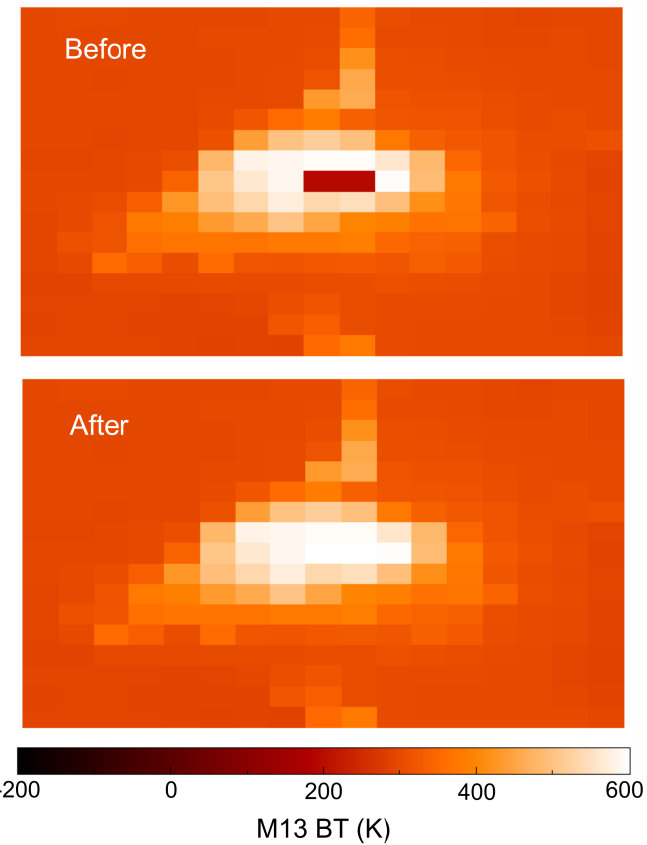
Figure 16. Comparison of M13 radiance (11 March 2014, 16:47 UTC) before (operational) and after the version 2 reprocessing.